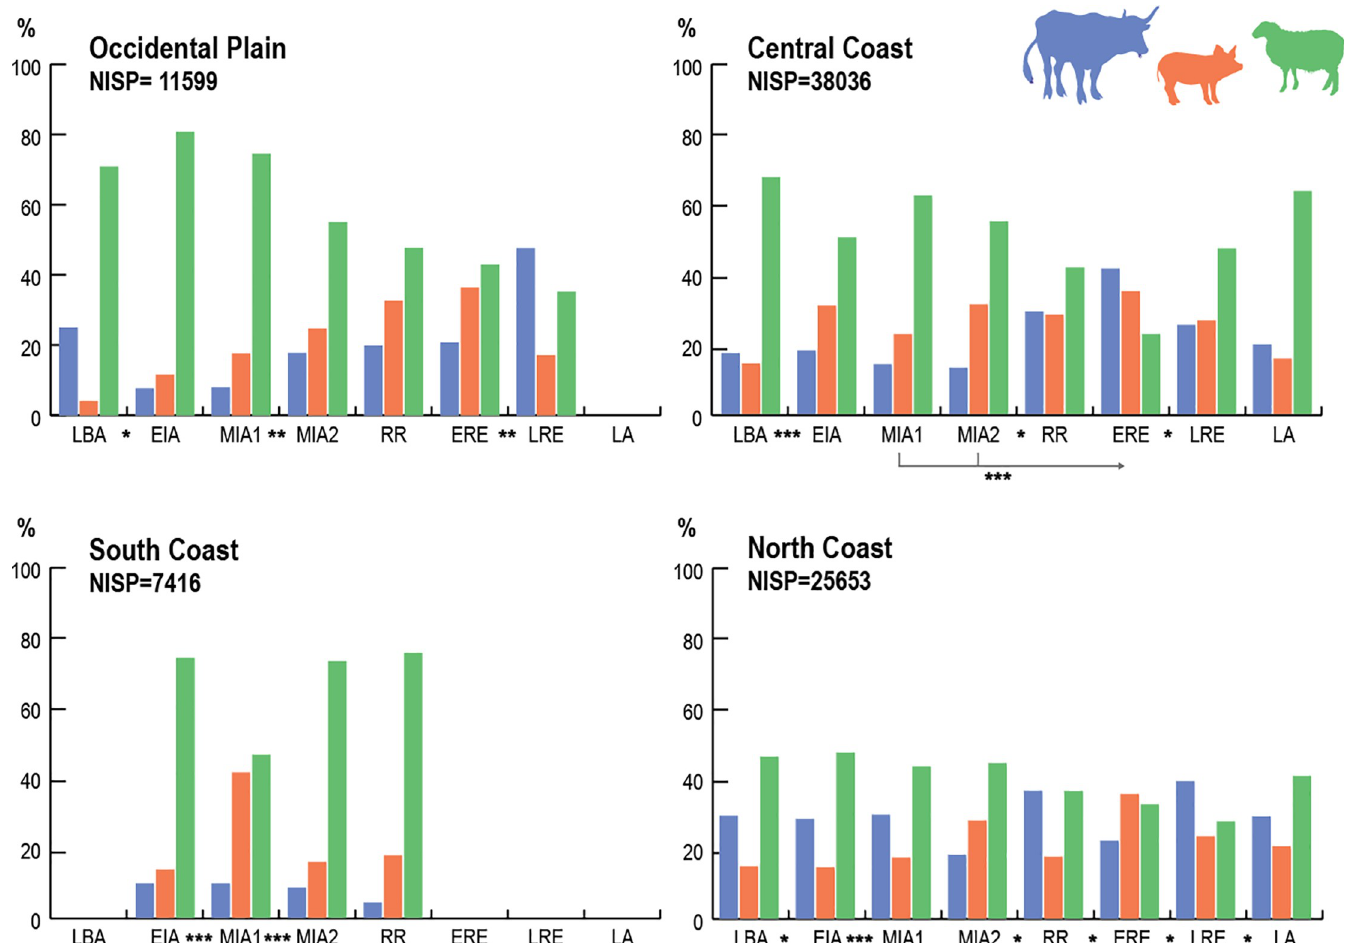
Fig 5. NISP percents of main domesticates (cattle, pig and sheep/goat) grouped by zones and ordered by periods. (LBA: Late Bronze Age, EIA: Early Iron Age, MIA1: Middle Iron Age 1, MIA2: Middle Iron Age 2, RR: Roman Republic, ERE: Early Roman Empire, LRE: Late Roman Empire, LA: Late Antiquity). Chi-square results showing significant changes between periods are displayed with their p-value : ��� : highly significant ( < 0.01); �� : significant ( < 0.05); � less significant ( < 0.1).